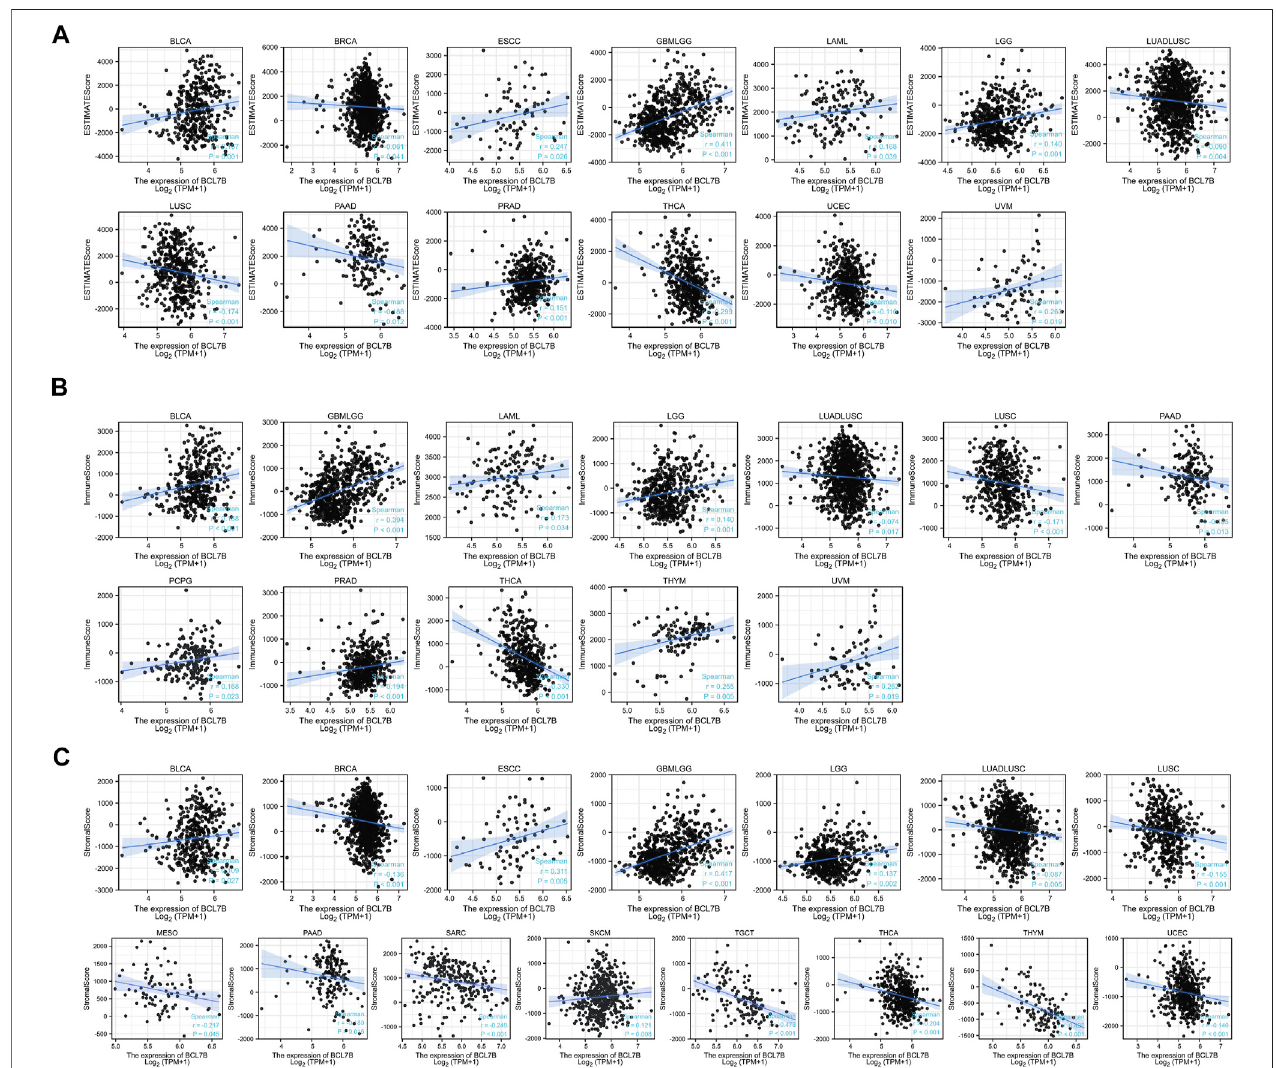
FIGURE 4 | Relationship between BCL7B gene expression and estimate score, immune score, and stromal score in 39 kinds of tumors. (A) Expression of BCL7B gene in the ESTIMATE immune score concerned with BLCA, BRCA, ESCC, GBMLGG, LAML, LGG, LUADLUSC, LUSC, PAAD, PRAD, THCA, UCEC, and UVM was prominently correlated. (B) Expression of BCL7B gene in the immune score was concerned with BLCA, GBMLGG, LAML, LGG, LUADLUSC, LUSC, PAAD, PCPG, PRAD, THCA, THYM, and UVM that are markedly correlated. (C) Expression of BCL7B gene in the stromal score was concerned with BLCA, BRCA, ESCC, GBMLGG, LGG, LUADLUSC, LUSC, MESO, PAAD, SARC, SKCM, TGCT, THCA, THYM, and UCEC that are notably correlated.